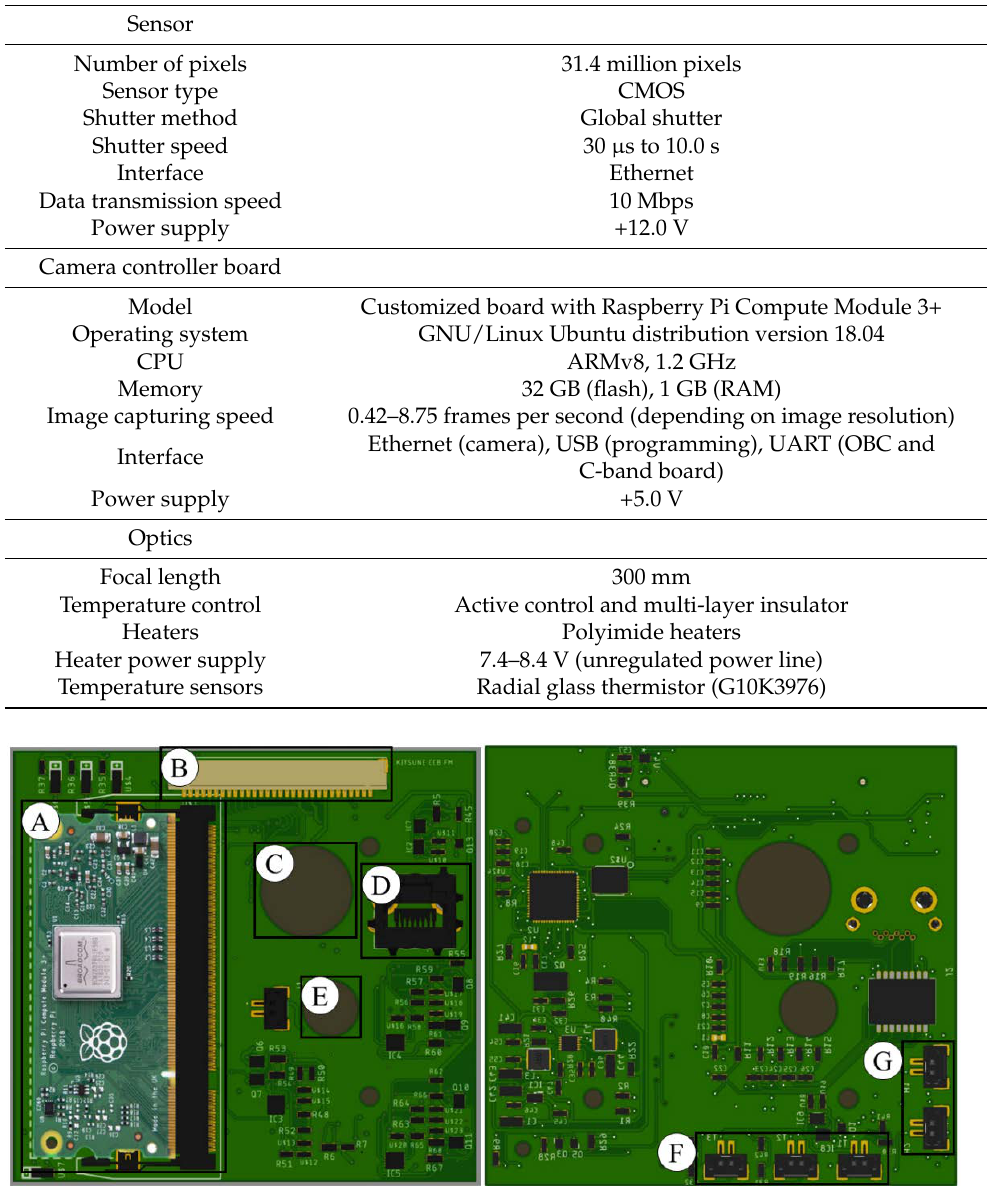
Figure 2. Camera Controller Board (CCB) design: (A) Raspberry Pi Compute Module 3+; (B) CCB-